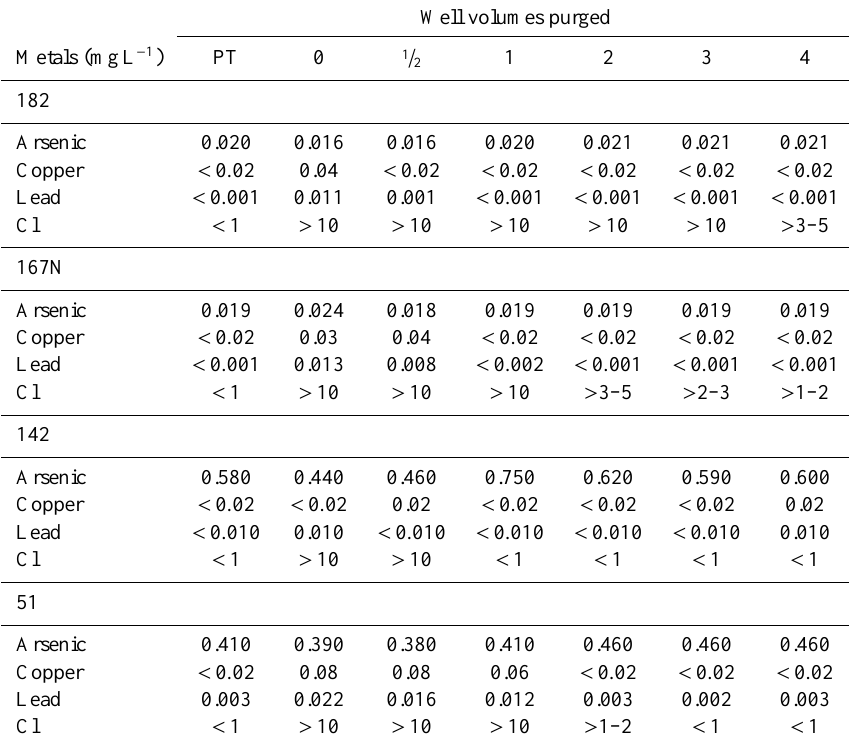
Table 5. Trace metal concentrations from pre-treatment (PT) through purging, expressed in number of well volumes pumped. The Maximum Contaminant Level for arsenic is 0.010mgL − 1 . Action Levels for lead and copper are 1.3 and 0.015mgL − 1 , respectively. Samples that contained analytes in concentrations less than the reporting limit (RL) are reported as “ < RL.” The reporting limit for lead varied according to results of internal laboratory quality control assessments and chemical quality of water